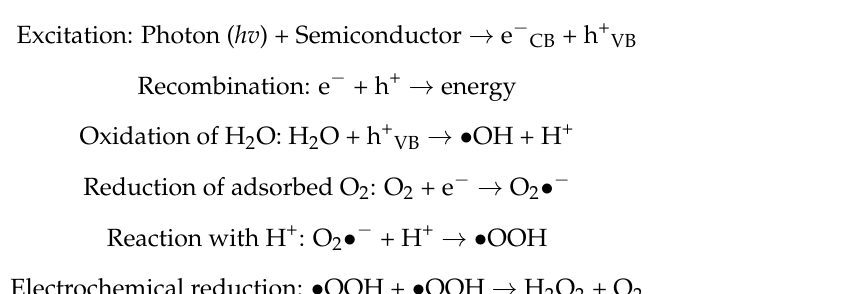
Figure 1. Schematic illustration of the photocatalytic reaction process of a semiconductor. Adapted with permission from Reference [18]. Copyright (2012)